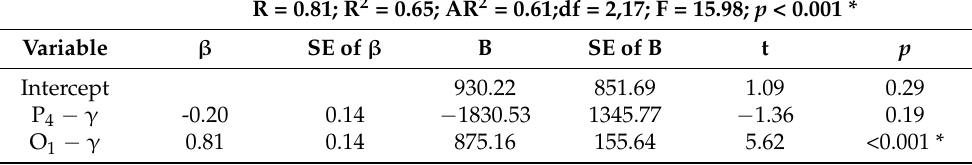
Table 10. Regression analysis for log-transformed total heart rate variability power and electroen- cephalography variables in train drivers.